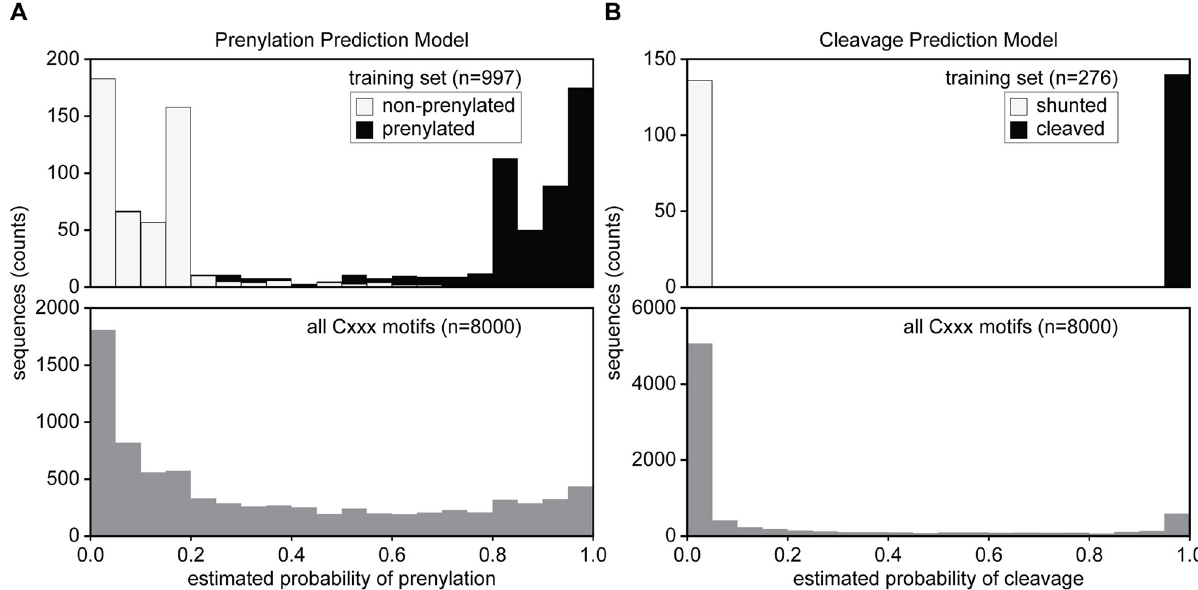
Fig 4. Probability distributions for prenylation and cleavage predictions made by SVM-ESM-1b. Probability distributions for both prenylation (A) and cleavage (B) determined for the training sets (top) and for all 8000 Cxxx motifs (bottom). A) For prenylation, the training set distribution is represented as a stacked bar plot where prenylated sequences are black, while non-prenylated sequences are white. B) For cleavage, the training set distribution is represented as a stacked bar plot where shunted sequences (prenylation only) are white and cleaved sequences for proteolysis are black. The probability distributions were determined for the training sets (top) and for all 8000 Cxxx motifs (bottom).